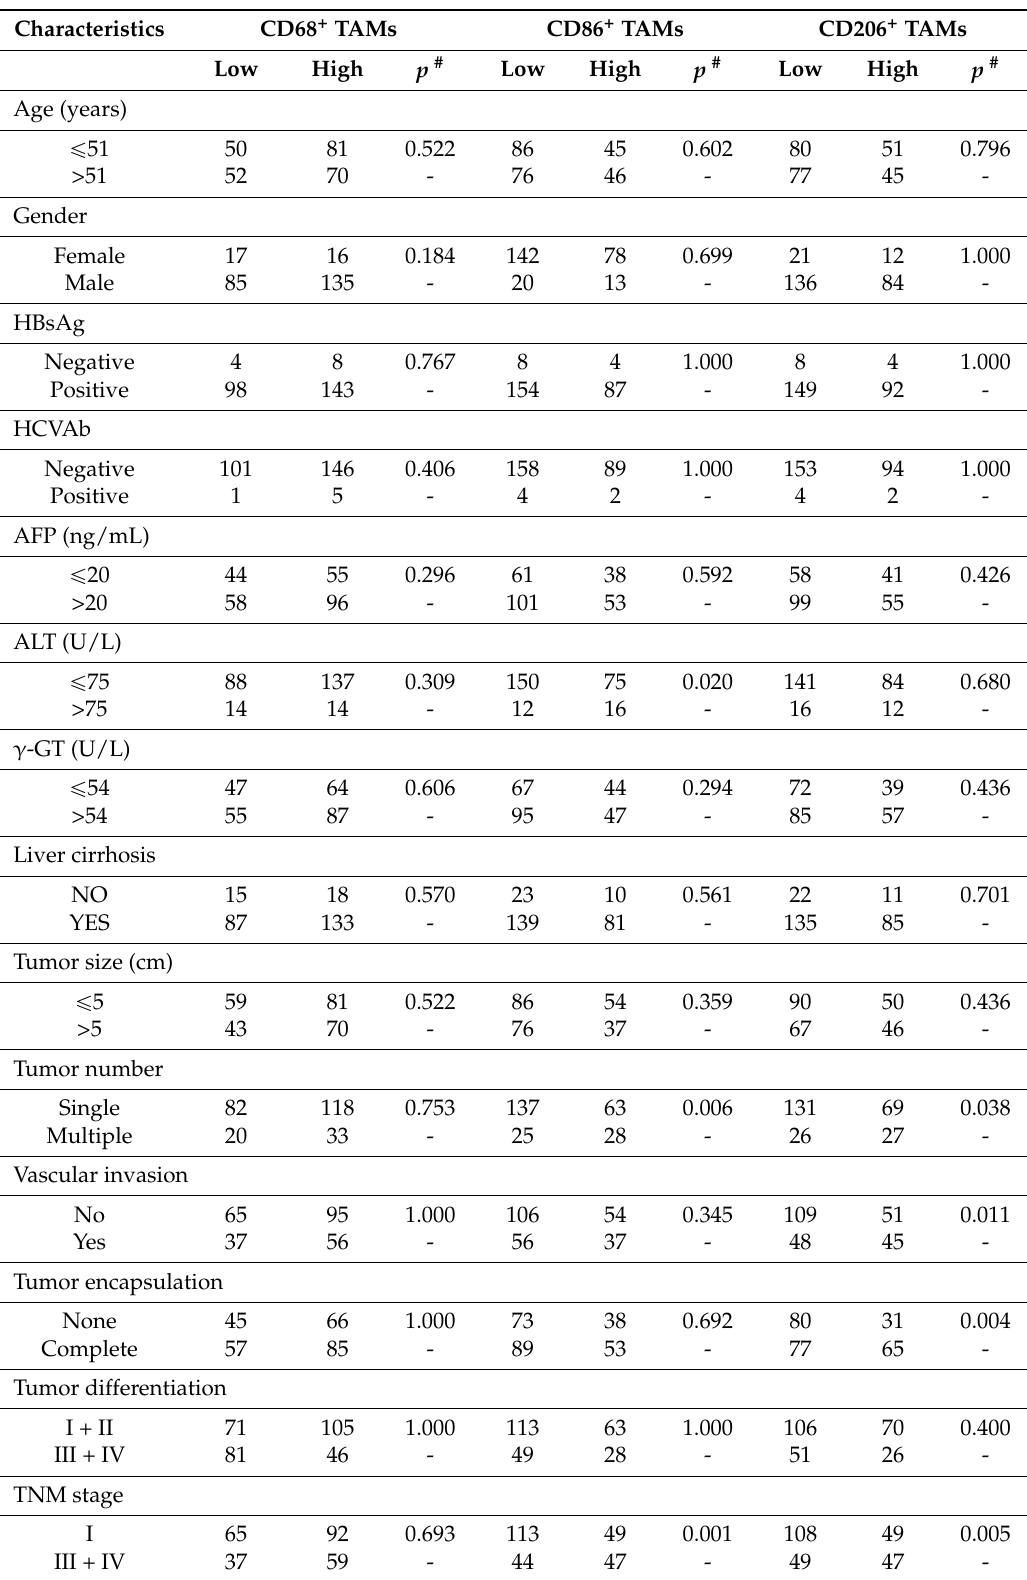
Table 1. Correlation between immunohistochemical variables and clinicopathologic features of HCC patients in the cohort ( n =